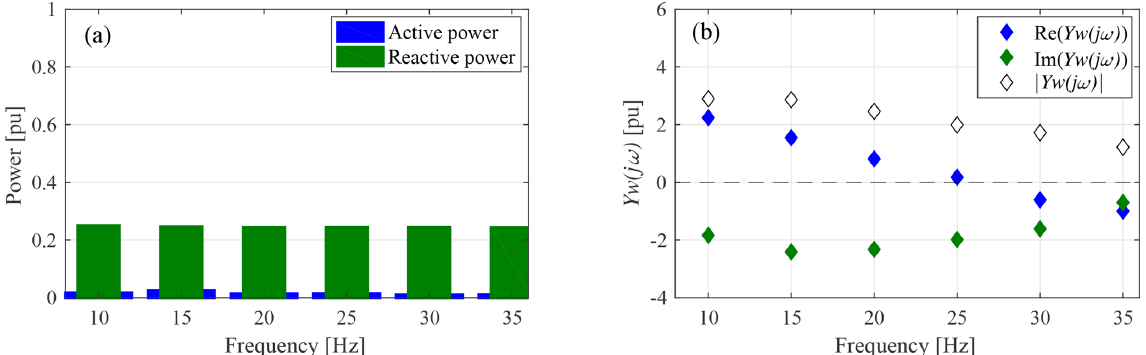
Figure 13. Results of frequency scan on wind turbine operated at 5% of power production: the operating points prior the scan and admittance components